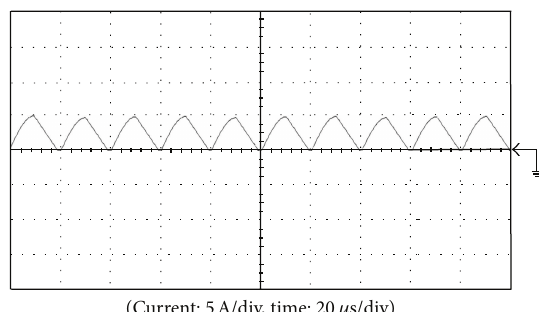
Figure 16: Simulated output inductor current while PV panel provides 350W.